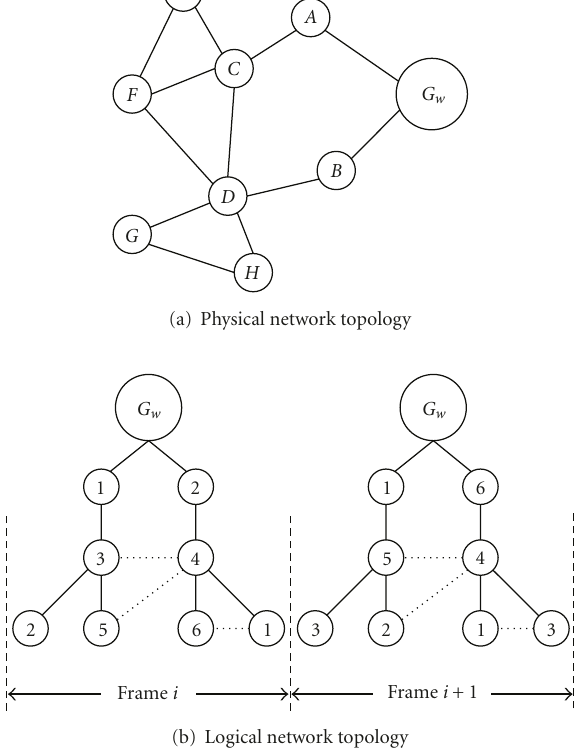
Figure 7: (a) Example network topology and (b) bits collision-free transmit schedule from